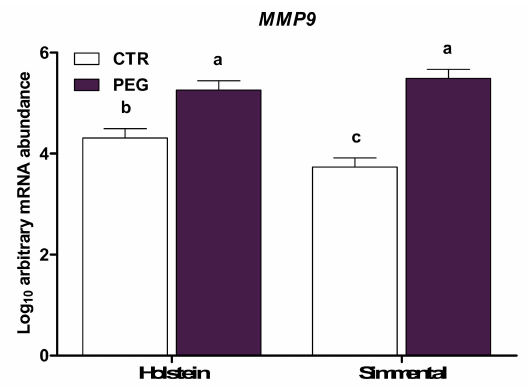
Figure 3. LSM ± SEM of Log10 arbitrary mRNA abundance for gene expression of MMP9 (matrix metallopeptidase 9) evaluated three days after calving in Simmental and Holstein cows treated either with pegbovigrastim (PEG) or with saline (CTR) at approximately Day 7 relative to calving and on the day of calving within 24 h. Di ff erent letters represent significant di ff erences among groups at p ≤